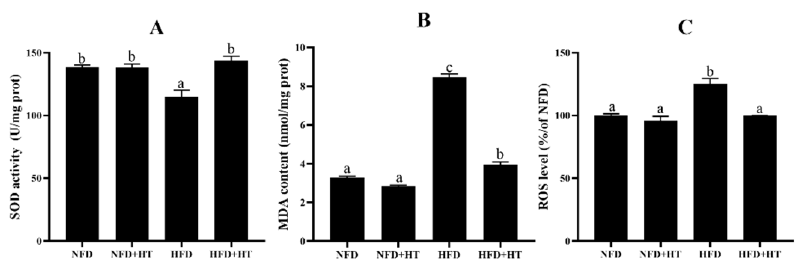
Figure 3. Superoxide dismutase activity (SOD: ( A )), malondialdehyde content (MDA: ( B )) and reactive oxygen species content (ROS: ( C )) in the liver of L. maculatus fed the test diets for 8 weeks. All values are exhibited as mean ± SE. The values with different superscripts (a, b, c) are significantly different at p < 0.05 (Tukey’s test).